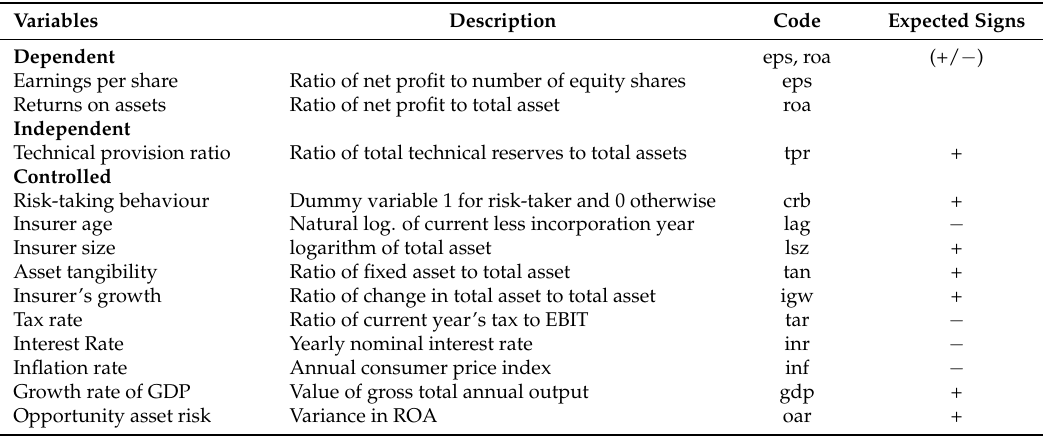
Table 1. Variables operationalization and expected